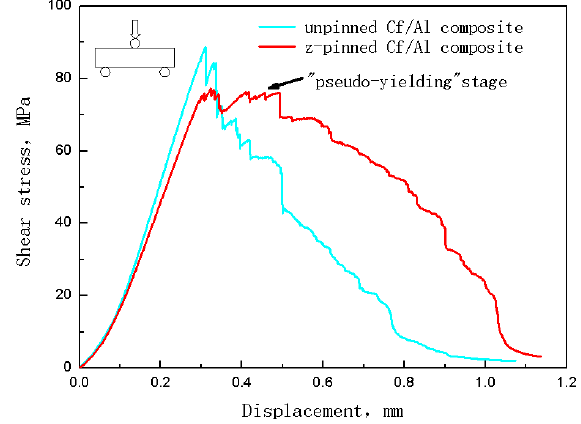
Figure 6. Typical shear stress-deflection curve of Cf/Al composites with and without z-pins. The steel pin’s geometric parameters’ effect on the extent of deflection in the pseudo-yielding, herein called the yield platform, was quantitatively evaluated. This evaluation of the yield platform defines its length, ∆ l , as the amount of deflection between the point of maximum shear stress and the point when the stress has decreased to 90% of the maximum value. Figure 7 shows this definition of the yield platform length. The influence of the volume content and diameter of the steel z-pin on the yield platform length is shown in Figure 8. This figure shows that as the volume content of the steel pin and the diameter increased, the length of the yield platform also increased. Tables 5 and 6 show the measured yield platform length experimental values for each group of z-pinned Cf/Al composites and unpinned Cf/Al composites as well as their standard deviations. In addition, the material maintained a